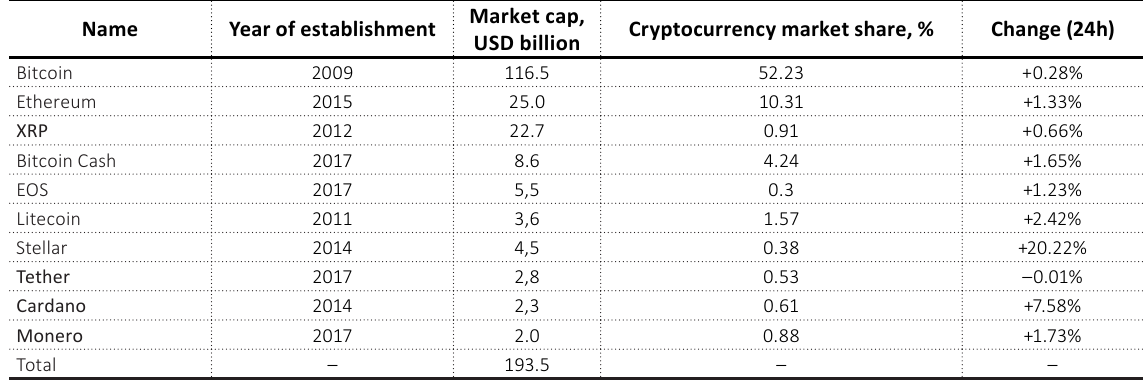
Table 1. Top 10 cryptocurrencies by market capitalization (September 23, 2018)